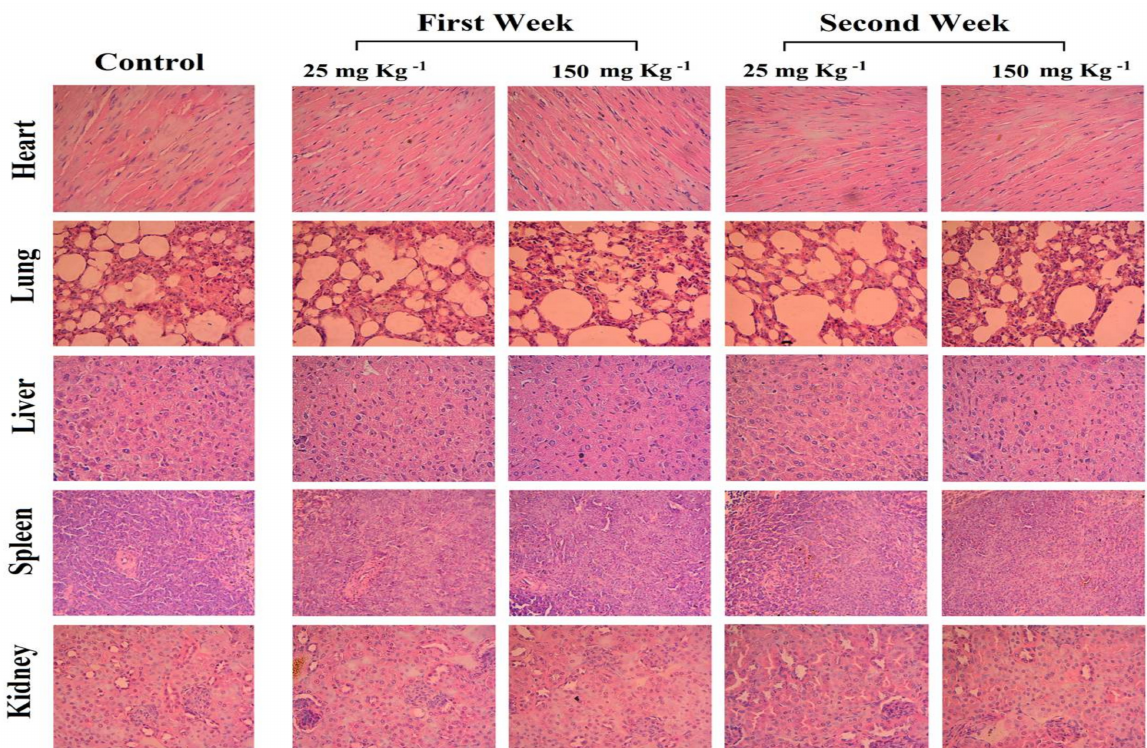
Figure 16. Photomicrographs of histological assessment of various mice organs after 7 and 14 days of inoculation intraperi- toneally with TAM/RES–LbL-LCNPs at doses of 25 and 150 mg kg − 1 . The liver, kidneys, heart, lung, and spleen were removed, and tissue sections were subjected to H&E staining, followed by a histopathological evaluation by light microscopy. Magnifications is 400X.